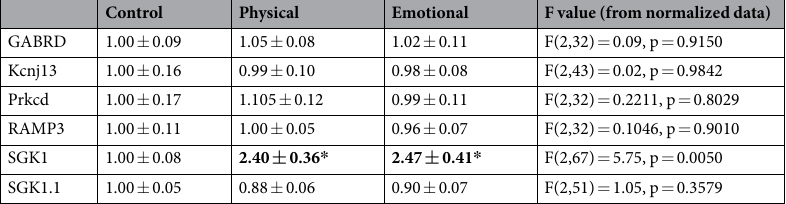
Table 3. RT-PCR analysis of candidate gene expression in the VTA of control, physical stress, and emotional stress mice 24 hr after social interaction testing (~48 hours after last day 10 d of chronic social defeat stress). Data are expressed as fold change + / − SEM, n = 11–25 mice/group.